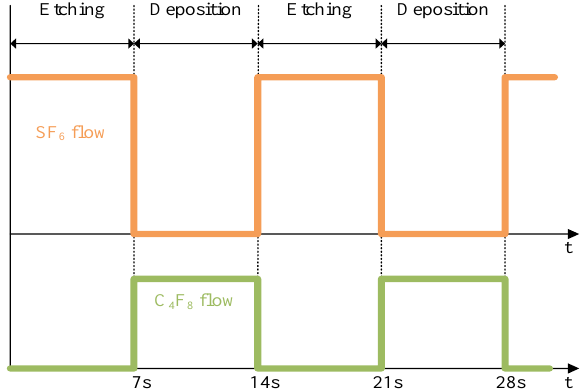
Figure 2. Schematic of alternating etching/passivation flow.